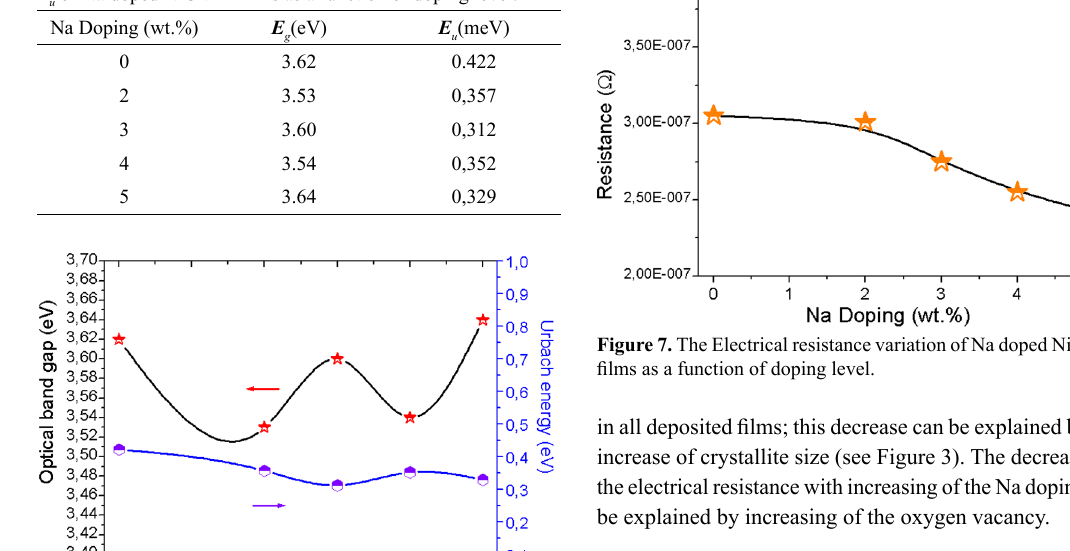
and the Urbach energy g